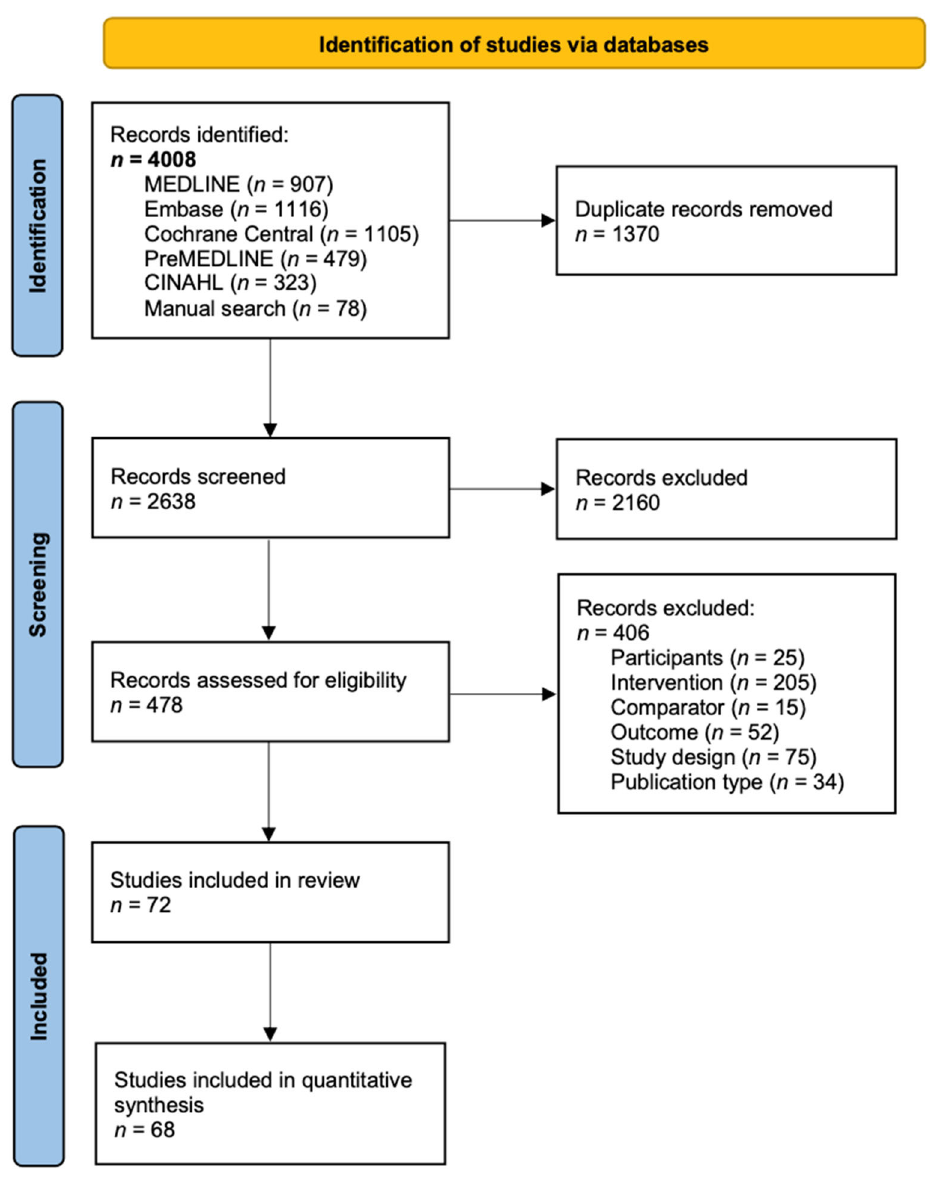
Figure 1. PRISMA flow diagram of study